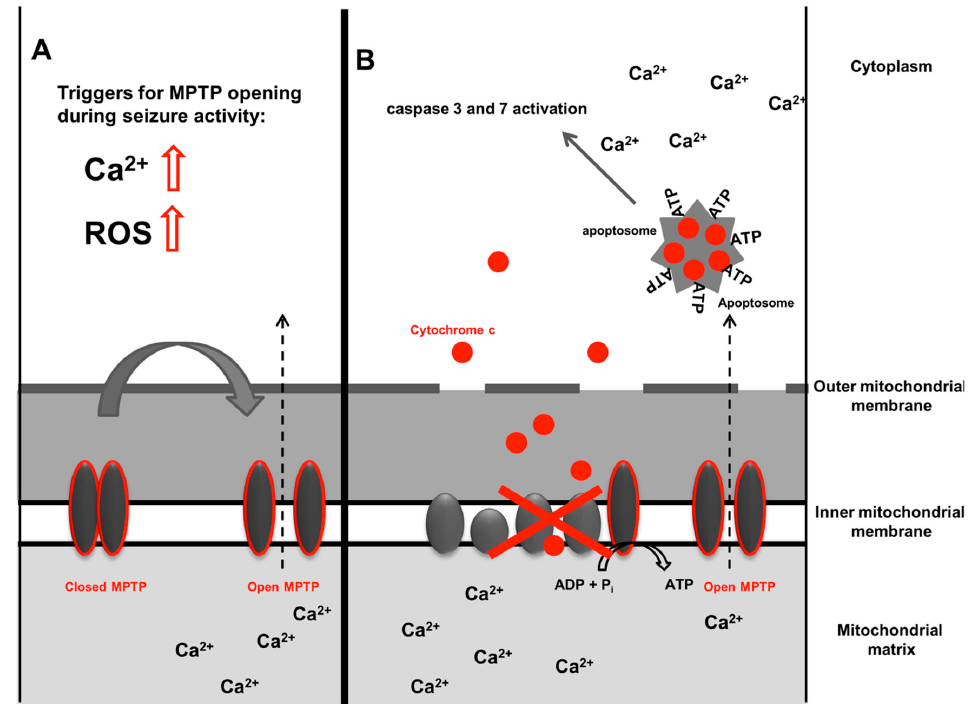
Figure 2. Mitochondrial permeability transition pore (MPTP) opening. Simplified model of the mitochondrial permeability transition pore. Permanent opening of the permeability transition pore leads to mitochondrial outer membrane permeabilization (MOMP). ADP: adenosine diphosphate; Pi: phosphate group; ROS: reactive oxygen species. Reduced function of the respiratory chain, as indicated with the red arrow (in B) subsequently leads to mitochondrial disintegration and release of cytochrome c.